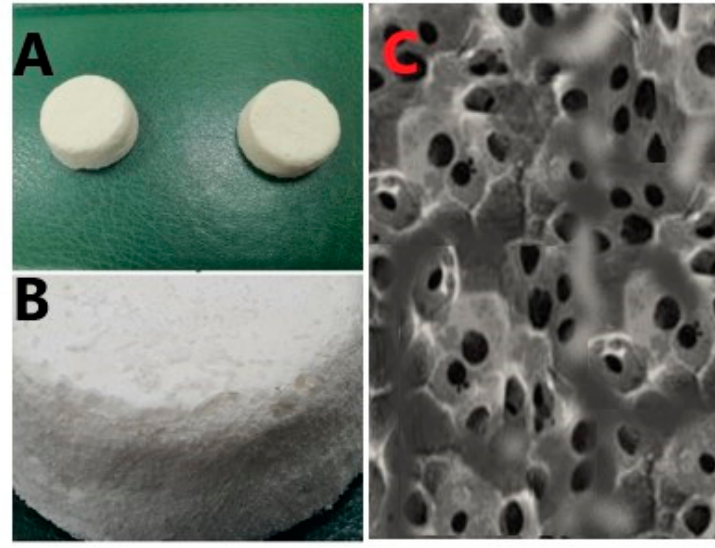
Figure 3. Photographs ( A , B ), and SEM image ( C ) for the prepared